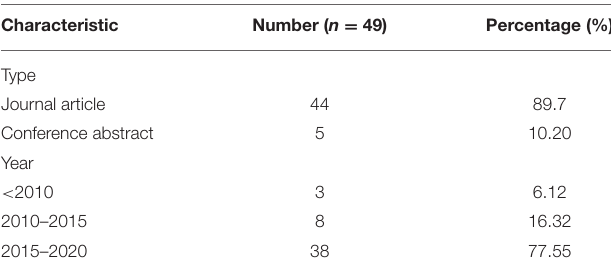
TABLE 1 | Detailed characteristics of included